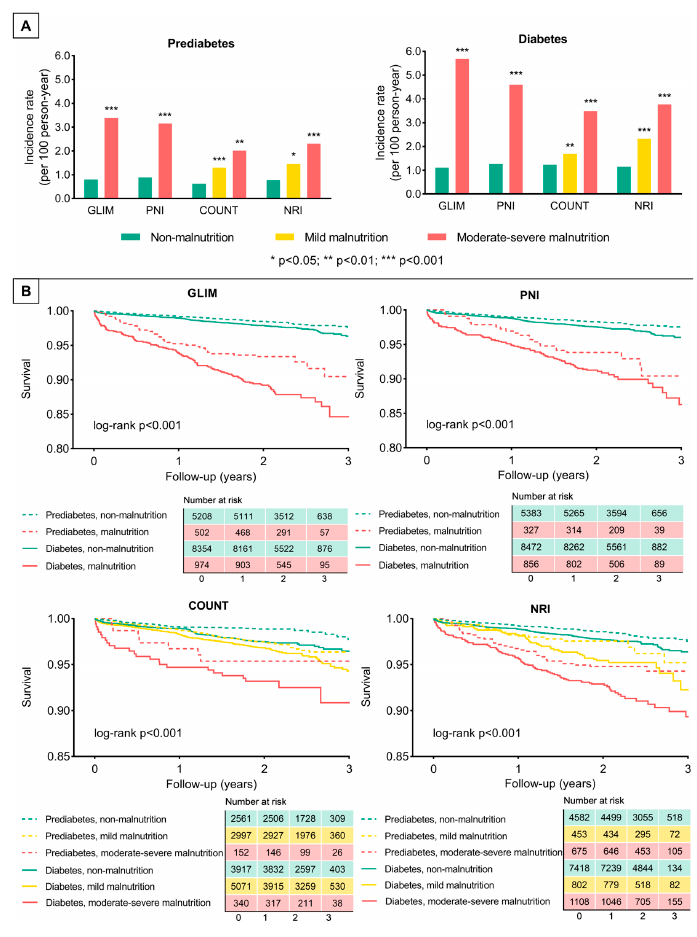
Figure 2. Incidences of all-cause death. ( A ) Incidence rate of all-cause death according to different assessment tools. ( B ) Survival curves by glycemic status and nutritional status according to each assessment tool. GLIM, global leadership initiative on malnutrition; PNI, prognostic nutritional index; COUNT, controlling nutritional status; and NRI, nutritional risk index. Compared with non-malnutrition, moderate–severe malnutrition was significantly associated with higher risks of all-cause death and MACCE, before and after adjustment (multivariable Cox analysis and propensity-score matching) (Table 3). Patients in a prediabetic state with malnutrition had higher hazard ratios for endpoint events than patients with diabetes without malnutrition. We examined and ruled out the presence of an interaction between the glycemic status and nutritional status (Figures S3 and S4). After the adjustment, mild malnutrition yielded no significant association with the risk of all-